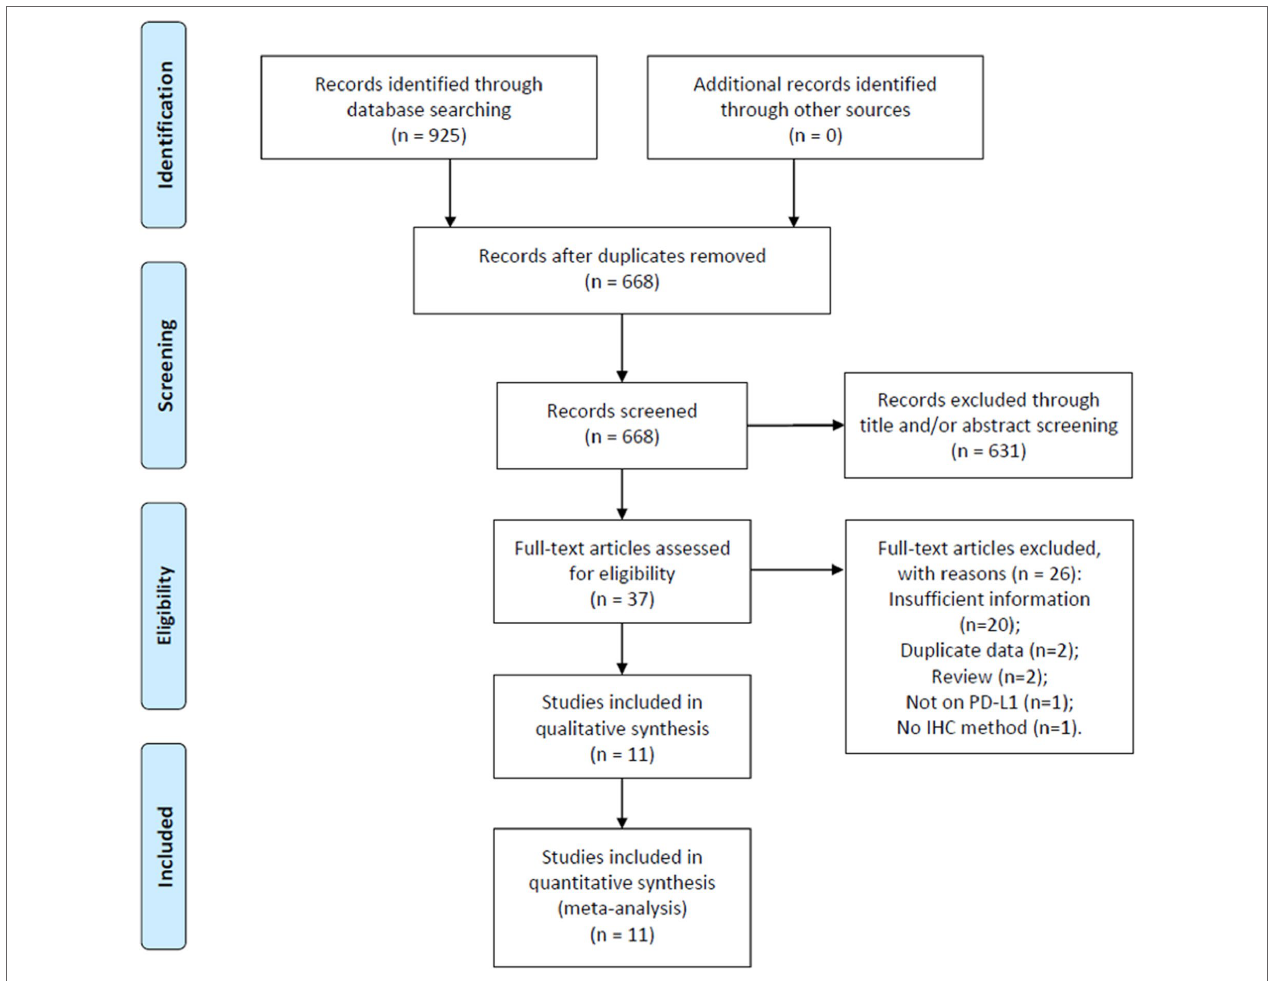
FIGURE 1 | Flowchart for selection of studies.